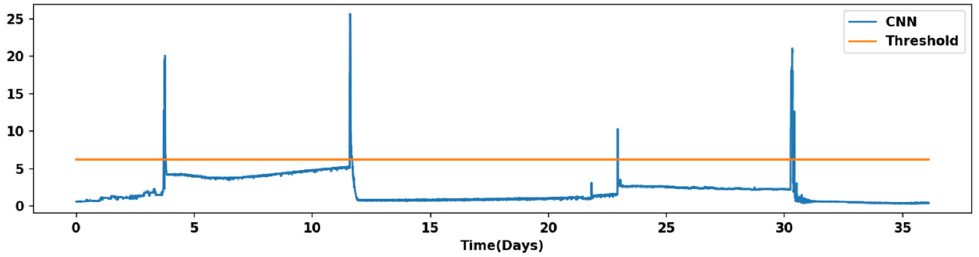
Figure 8. Diagram of CNN autoencoder restoring error value and threshold.